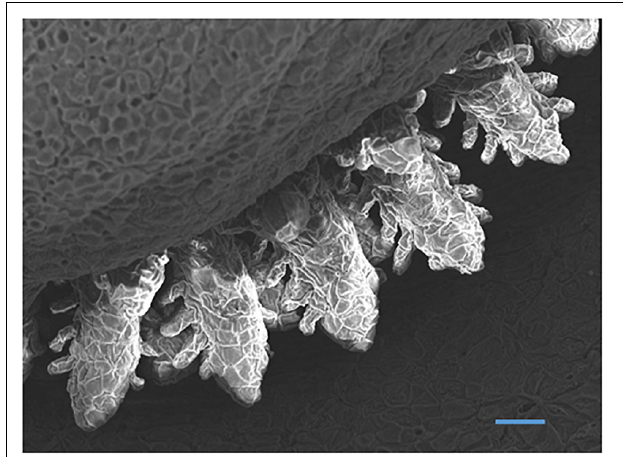
FIGURE 5 | Scanning electron micrograph of developing gills in yolk-sac larvae of Nile tilapia at hatch showing filaments with budding secondary lamellae (Bar = 50 µ m) (Fridman,